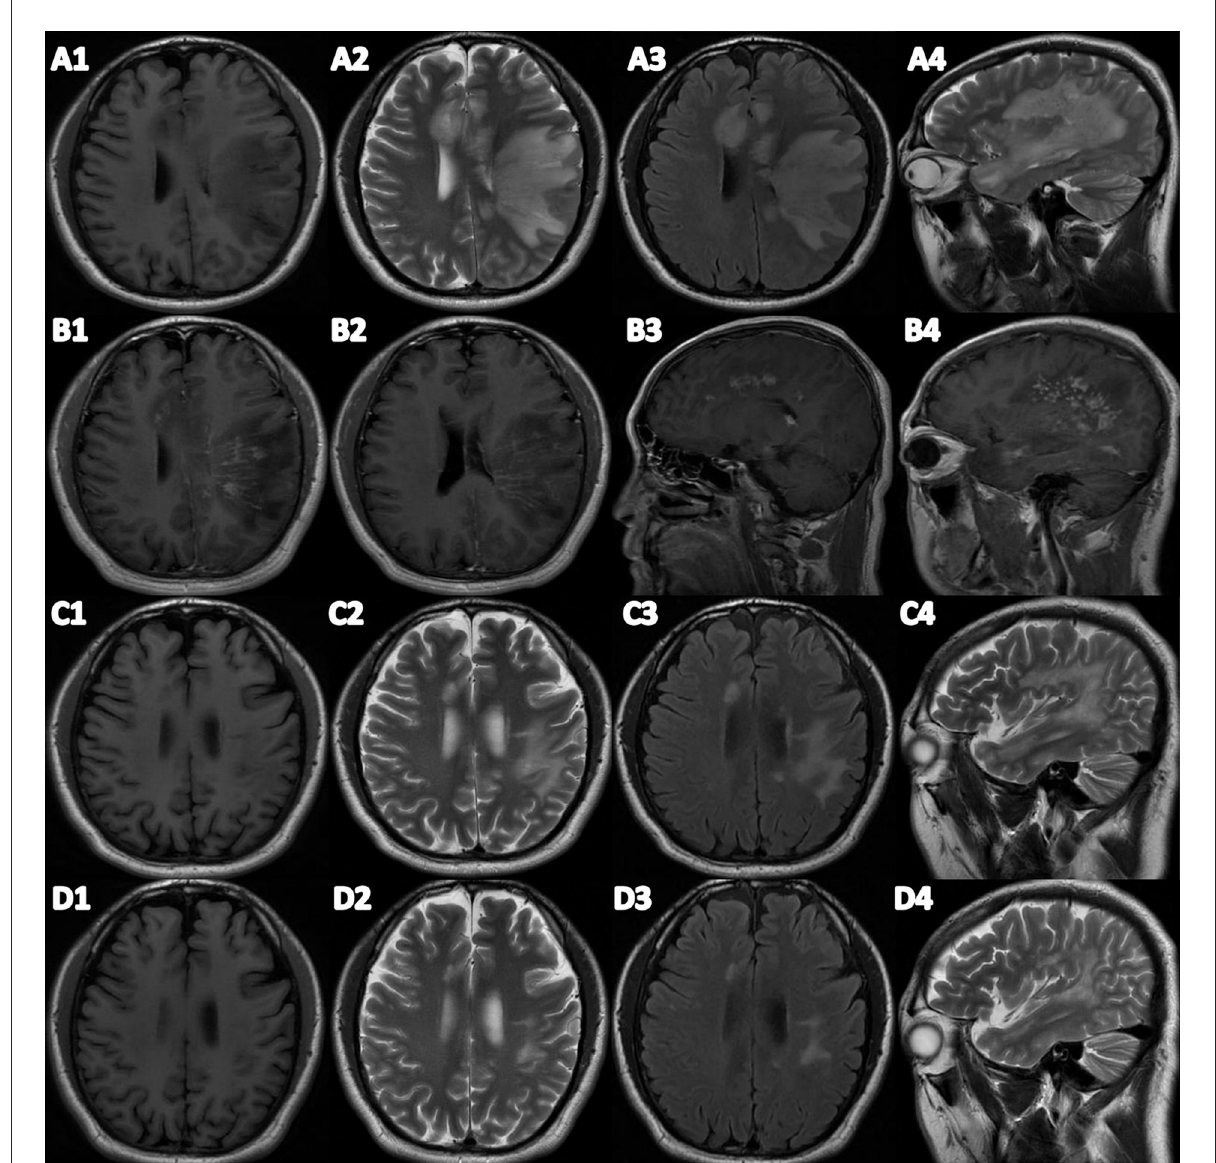
FIGURE1 (A1–A4) Brain plain MRI before treatment. (B1–B4) Brain T1-enhanced MRI. (C1–C4) Brain plain MRI after treatment. (D1–D4) Brain plain MRI after 3 months of treatment. (A1/C1/D1) Transverse T1 weight imaging. (A2/C2/D2) Transverse T2 weight imaging. (A3/C3/D3) Fluid